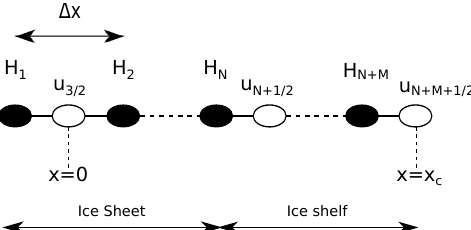
Figure 4. Illustration of the staggered grid used in the model. The H -grid points are represented by solid circles and the u -grid points by empty circles. 1x is the grid spacing (on both H - and u -grids). H N is the ice thickness in the last grounded point. The ice divide is at x = 0 and the calving front at x = x c